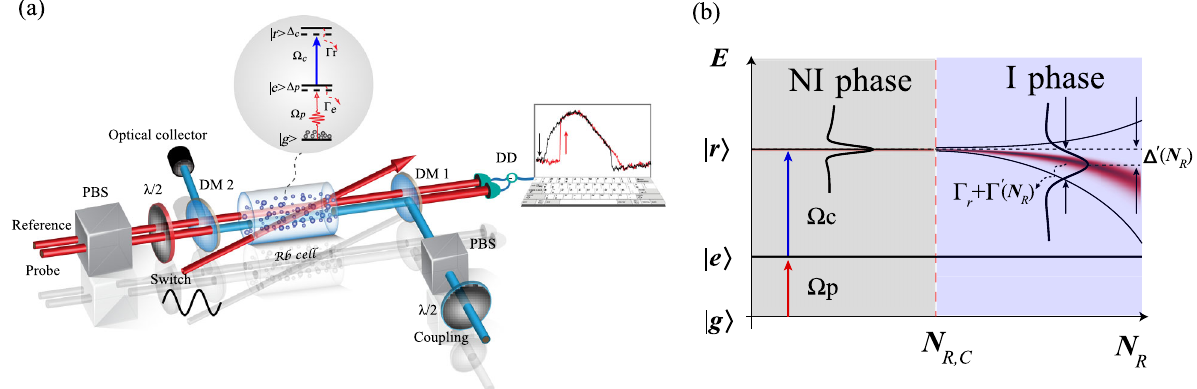
FIG. 1. (a) Overview of experimental setup. A probe and an identical reference beam are propagating in parallel through a heated Rb cell (length 5 cm). The probe beam is overlapped with a counterpropagating EIT coupling beam. Their transmission signals are detected ; F ¼ 3 i → j e i ¼ j 5 P 1 ; F 0 ¼ 2 i , and the on a differencing photodetector (DD). The probe and reference fields drive the j g i ¼ j 5 S 1 = 2 = 2 transition in 85 Rb. A switch beam can be added to enhance the Rydberg population coupling light couples the j e i → j r i ¼ j nD 3 = 2 i without changing the probe intensity. PBS is for polarizing beam splitter, DM is for dichroic mirror, and λ = 2 stands for half-wave plate. (b) Excitation and interaction dynamics in the different phases. In the noninteracting (NI) phase, the probe transmission under EIT conditions remains unaffected. Above a critical Rydberg atom density N , the system is found in an interacting (I) phase, where R; ð c Þ strong interactions lead to energy shifts and enhanced decay of j r i